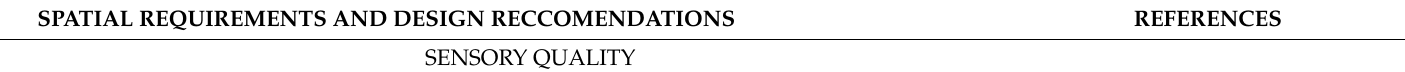
Table 3. Autism friendly spatial